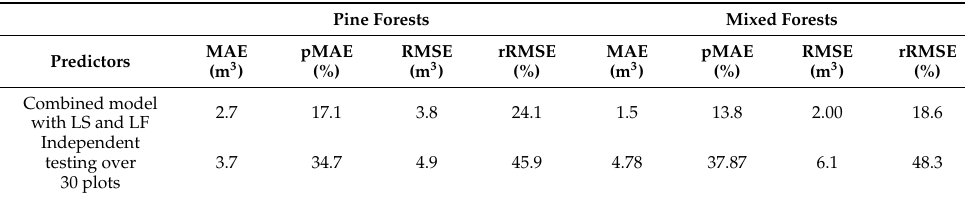
Table A1. Corresponding RMSE and rRMSE metrics for the combined model applied in scaling stem volume estimates across the study area. LS indicates Landsat based predictors at specified date, LF indicates LANDFIRE based predictors. Number of pixel samples used was 2269 and 2226 for pines and mixed forests, respectively.